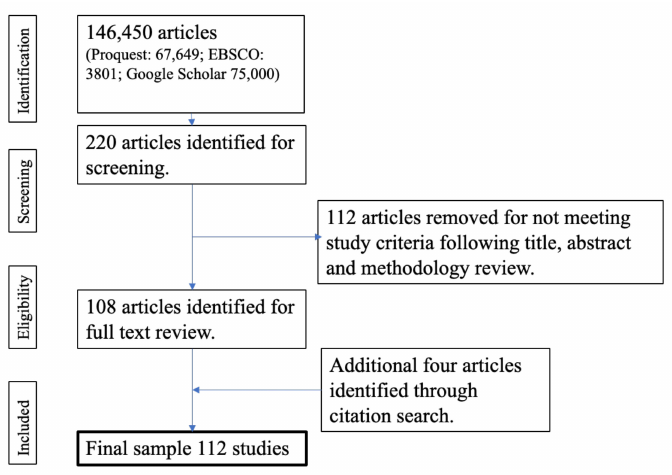
Figure 1. PRISMA flowchart for this